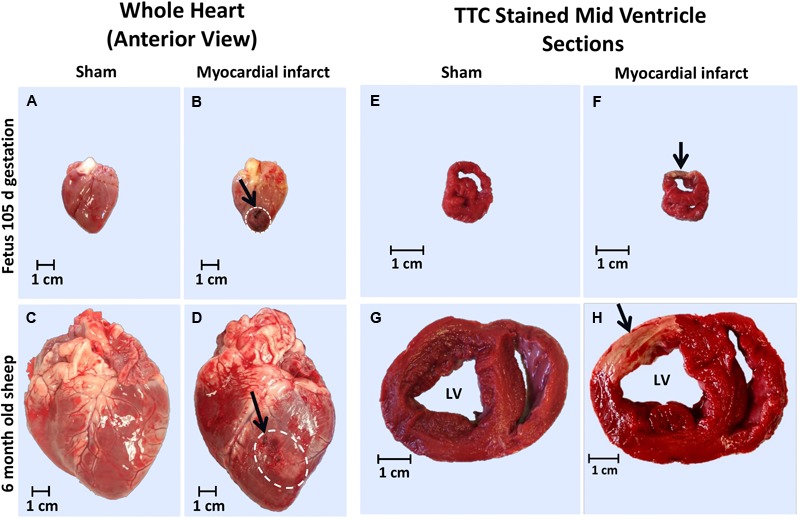
Representative gross heart tissue and TTC stained sections from 105 days fetus and 6 month old adolescent sheep 3 days after MI. Whole hearts at post-mortem of: (a) 105 days fetal sham, (b) 105 days fetal MI, (c) adolescent sham, and (d) adolescent MI sheep (arrows and white dashed area indicates ligation site and infarct area respectively); TTC stained heart sections of: (e) 105 days fetal sham, (f) 105 days fetal MI, (g) adolescent sham, and (h) adolescent MI sheep (arrow indicates infarct area).